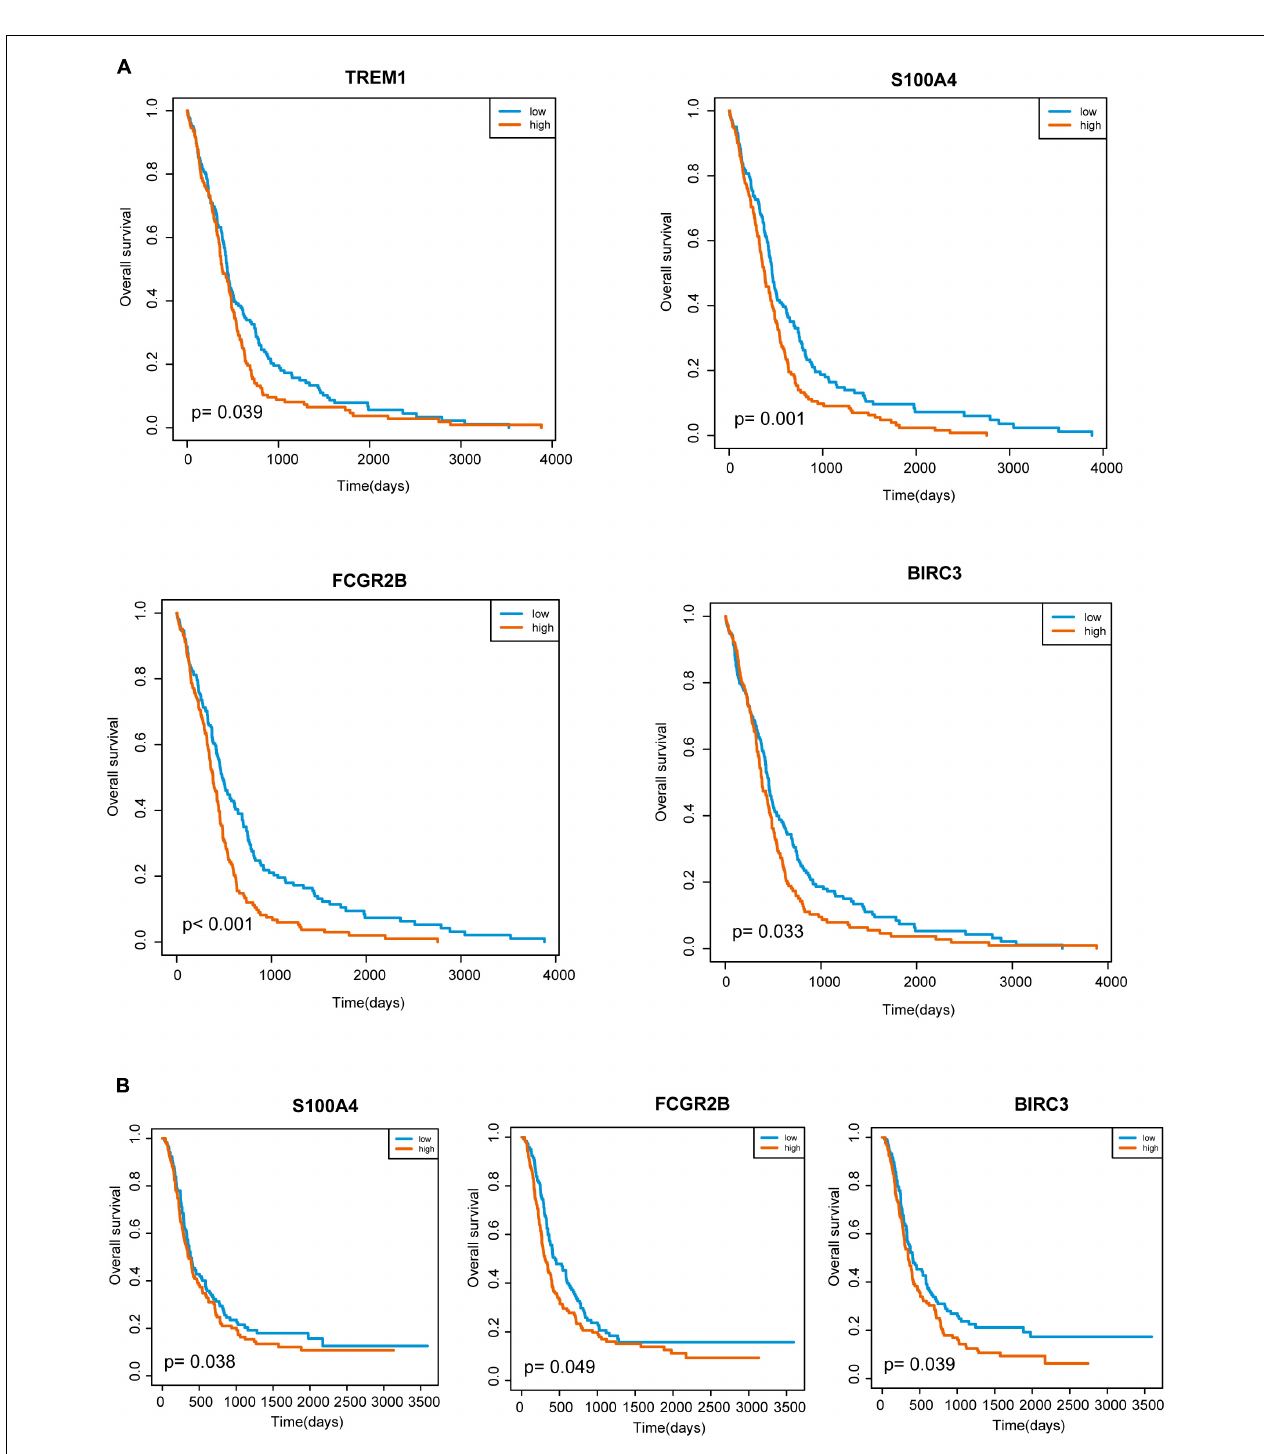
FIGURE 4 | Survival analysis of targeted molecular therapy associated key genes. (A) Four genes are potential prognostic biomarkers in TCGA GBM dataset. (B) Three out of the four genes are stable survival associated in test data.